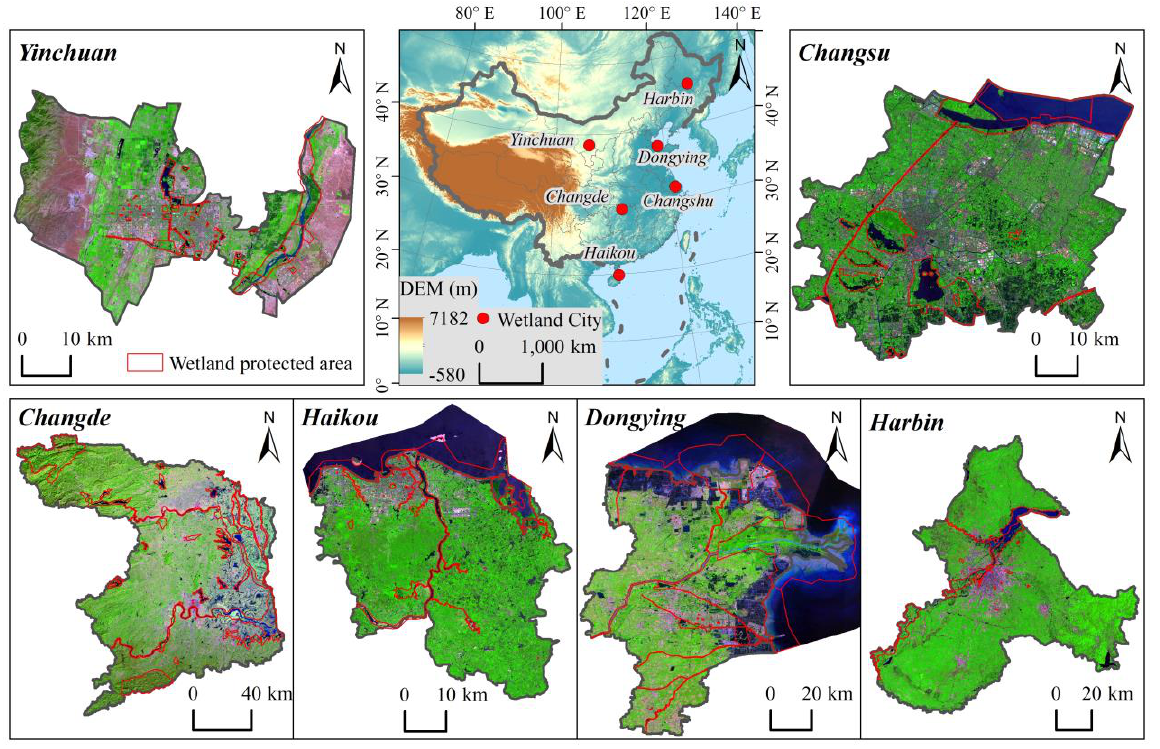
Figure 1. Map of the first Chinese wetland cities (false colour composite based on R: Band 12, G: Band 8, B: Band 4 from the Sentinel-2 sensor). Table 1. Area and wetland information about Chinese wetland cities (the area of brackets indicates the area, including coastal extension regions).